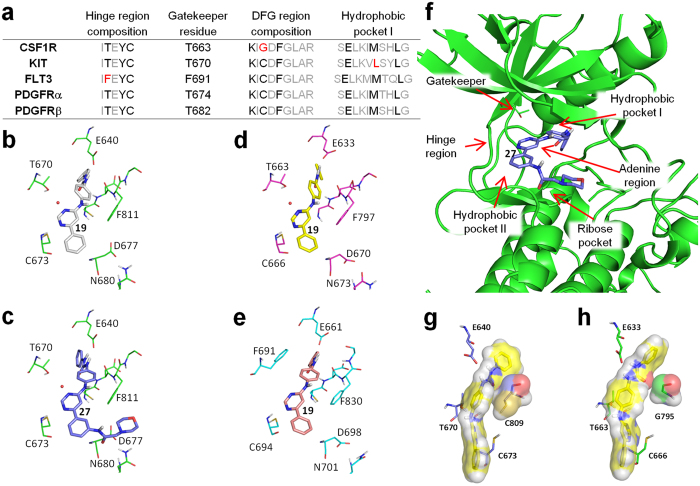
Binding mode study on compounds 19 and 27.(a) Sequences of hinge, DGF and hydrophobic pocket I regions of the ATP binding pocket for class III RTKs. Black (or red) characters indicate amino acids that place the side chain inside the ATP-pocket; grey characters indicate the amino acids that place the side chain outside the ATP-pocket. Amino acids that place the side chain inside the ATP-pocket and that differ between the five kinases are highlighted in red. The gatekeeper residue number is also reported. (b–f) Results of docking simulations: (b) Potential binding mode of 19 (gray stick) with KIT (green sticks); (c) Potential binding mode of 27 (blue stick) with KIT (green sticks); (d) Potential binding mode of 19 (yellow sticks) with CSF1R (pink sticks); (e) Potential binding mode of 19 (light pink sticks) with FLT3 (cyan sticks); (f) Potential binding mode of 27 (blue sticks) with KIT (green sticks and green cartoons), in context with the ATP binding site features. The 6-phenyl moiety of compound 27 is placed in the hydrophobic pocket II, whereas the hydrophilic function (i.e. the morpholine ring) is placed in the ribose pocket. (g,h) Details of docking simulations for compound 19 (yellow sticks) in KIT (blue sticks, panel (g)) and CSF1R (green sticks, panel (h)). Compound 19, KITC809 and CSF1RG795 are depicted as transparent surfaces. The gatekeeper residues (KITT670 and CSF1RT663) as well as other protein residues are depicted as sticks in order to allow a better comprehension of the compound binding modes.